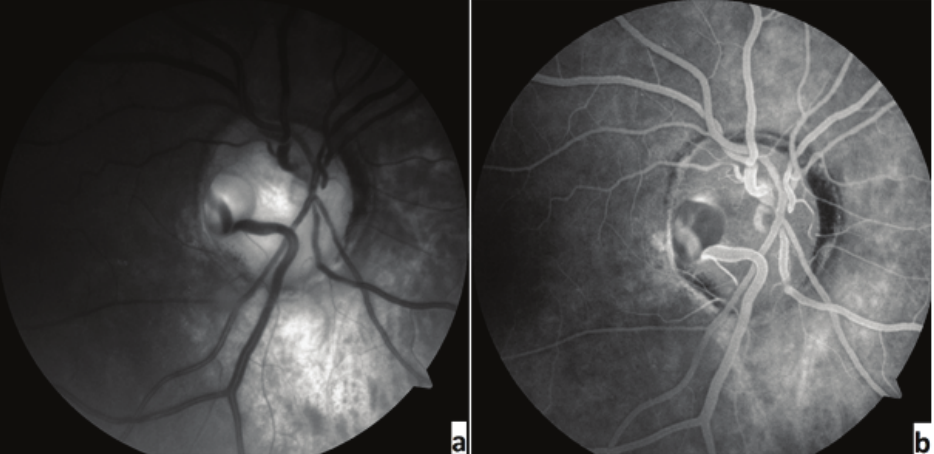
Figure 5. (a&b) Fundus fluorescein angiography shows the filling of the retinochoroidal vein in the early and late phases.